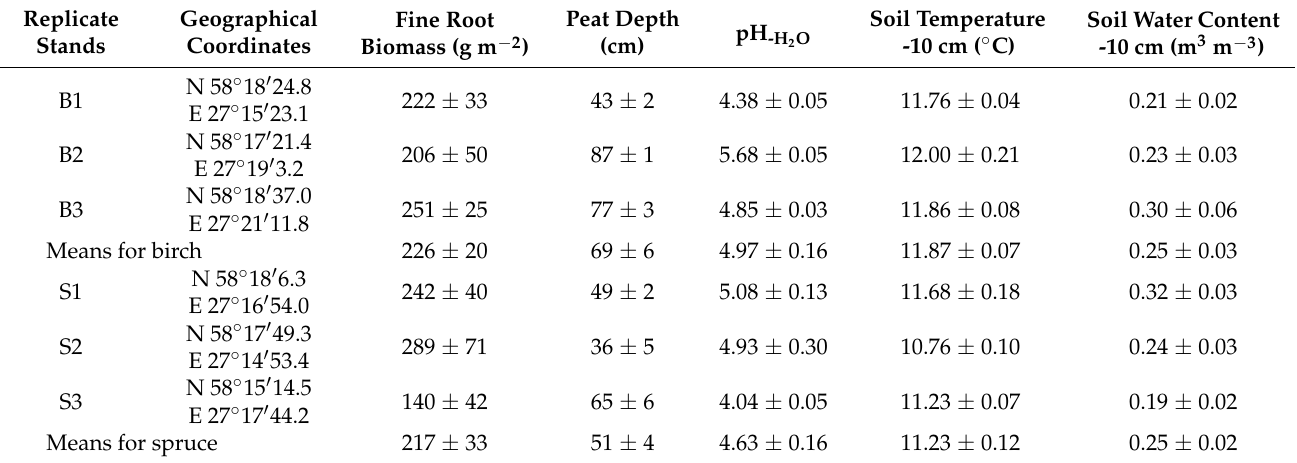
Table 1. Geographical coordinates, and means ± standard errors of fine root biomass and soil characteristics of the four sampling plots per stand (B1–B3, birch stands; S1–S3, spruce stands) and of the three replicate stands per birch and spruce